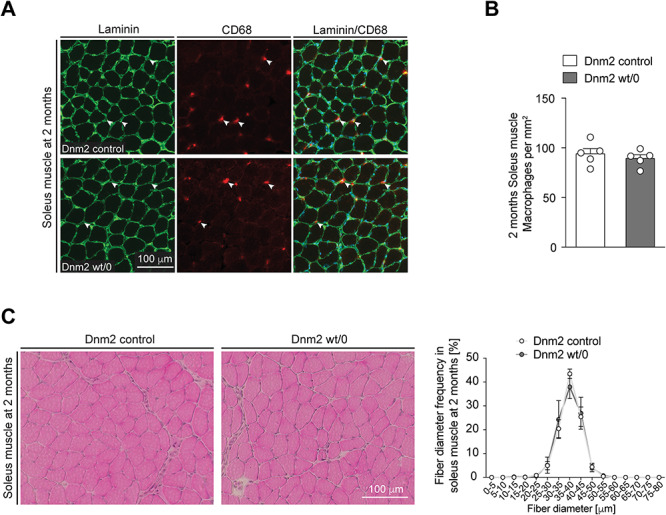
DNM2 haploinsufficiency is not the likely underlying mechanism of the myopathy in Dnm2 K562E mice. (A) Exemplary cryosections of soleus muscles derived from 2-month-old control and Dnm2 wt/0 mice probed with antibodies targeting laminin or CD68. Exemplary CD68-positive macrophages (white arrowheads) are highlighted. Scale bar: 100 μm, refers to whole panel. (B) Quantification of CD68-positive macrophages in between myofibres reveals no significant changes between control and Dnm2 wt/0 muscles at 2 months. Bar heights, mean; error bars, SEM (n = 5 mice/genotype, images from two to three sections quantified and averaged per mouse). (C) (Left) Exemplary H&E-stained soleus muscle cryosections derived from control and Dnm2 wt/0 mice at 2 months. Scale bar: 100 μm, refers to whole panel. (C) (Right) Quantification of myofibre diameter frequency reveals no detectable difference between both genotypes on soleus muscle sections at 2 months. Datapoints, mean; error bars, SEM (n = 5 mice/genotype, images from three sections quantified and averaged per mouse). Two-tailed unpaired Student’s t-test (B) and two-way ANOVA with Sidak’s multiple comparisons test (C).